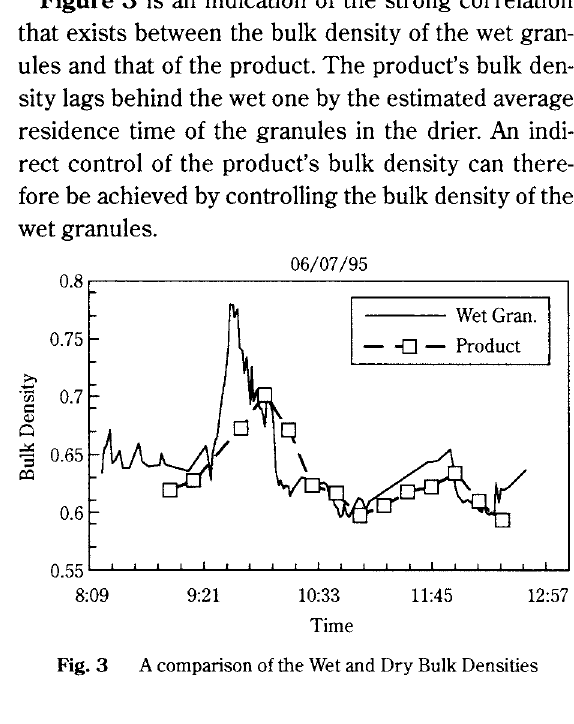
A comparison of the Wet and Dry Bulk Densities The Model Development